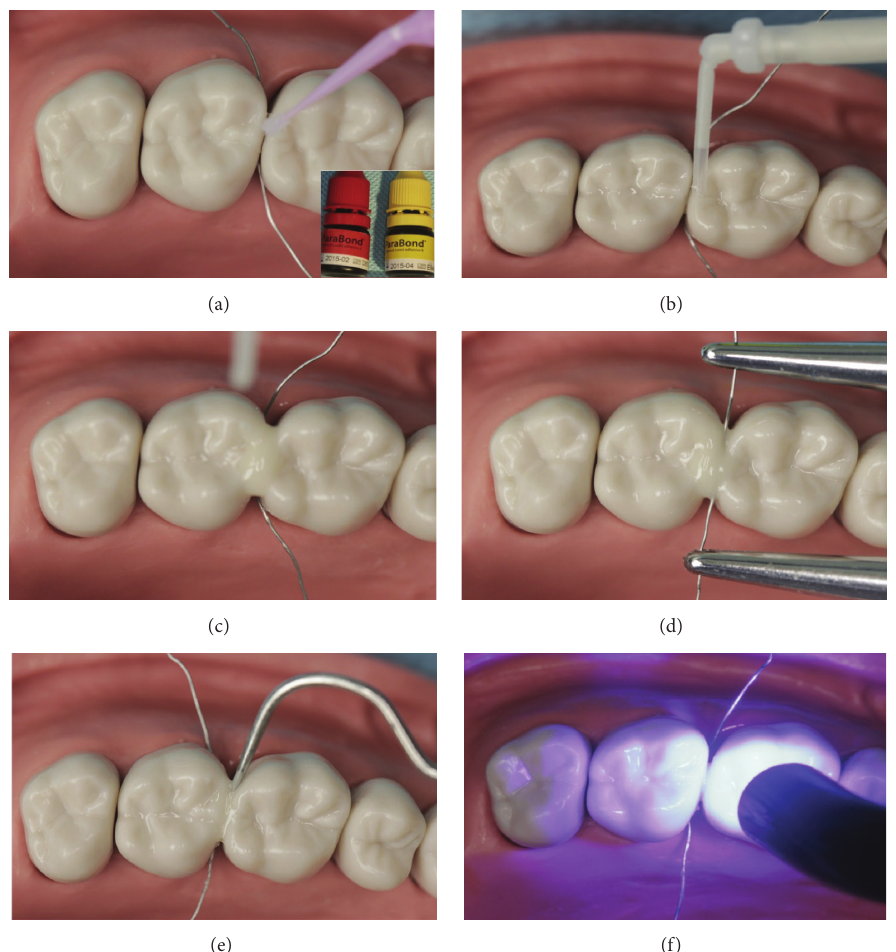
Figure 4: Applying flowable composite resin or composite resin cement to rebuild the contact area under tension stress with the cerclage wire. (a) Applying the primer and bond resin to the etched surface. ((b), (c)) Injecting the flowable composite resin or composite resin cement around the contact area. (d) Enforcing the tension band with the cerclage wire for about 30 s to squeeze the paste of composite resin into the contact area. (e) Relieving the tensile stress and removing the redundancy immediately with a point probe. (f) Light curing from all aspects.